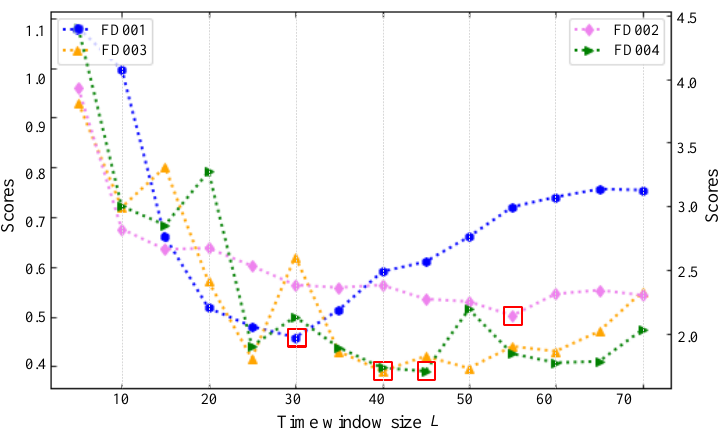
Figure 9. The scores of different time window sizes for four sub-datasets.